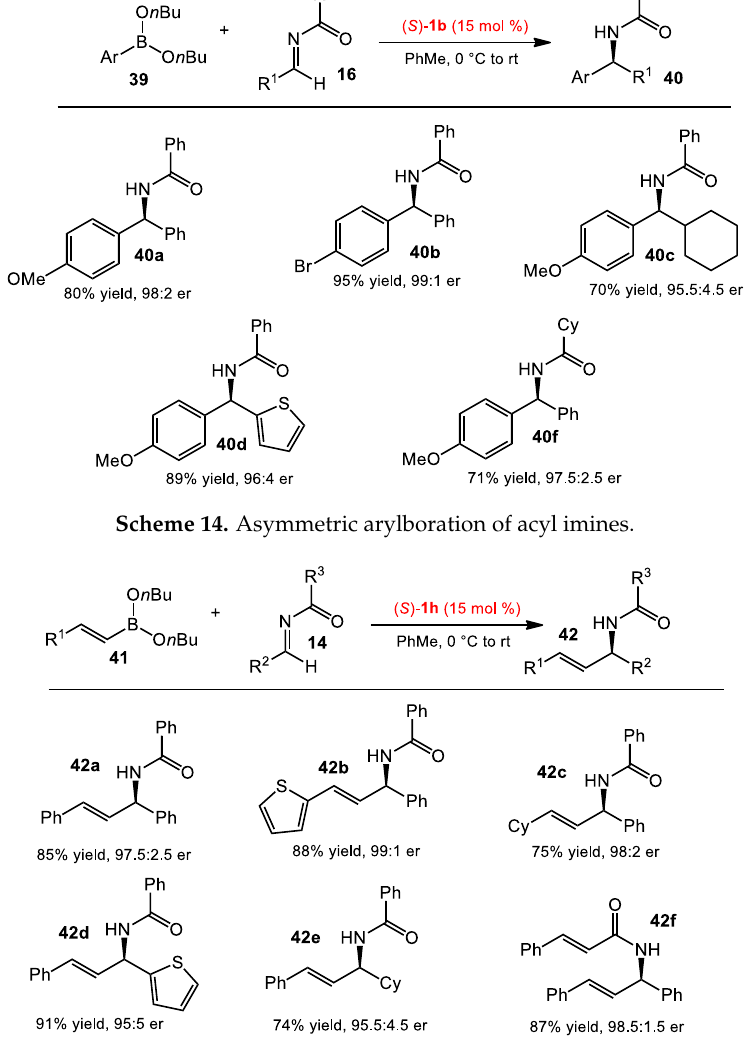
Scheme 15. Asymmetric vinylboration of acyl imines.